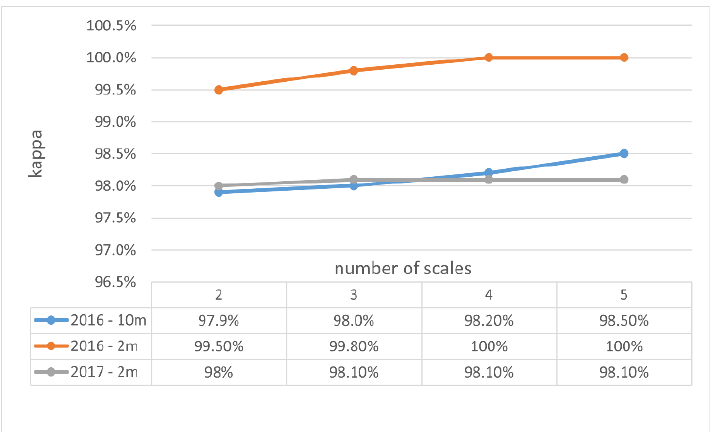
Figure 17. Cohen’s 𝜅 of the classification maps with respect to the test samples as a function of the number of scales 𝑄 used in the Markovian fusion framework.